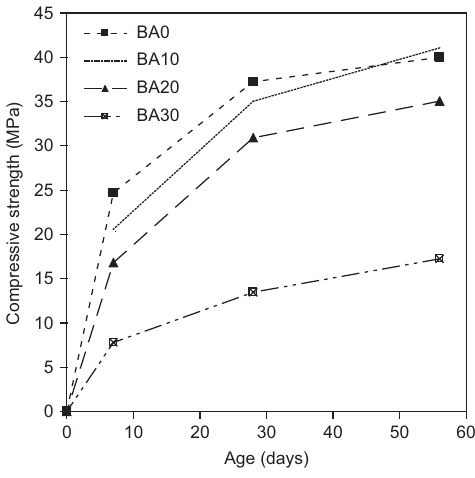
Figure 5 Compressive strength vs.